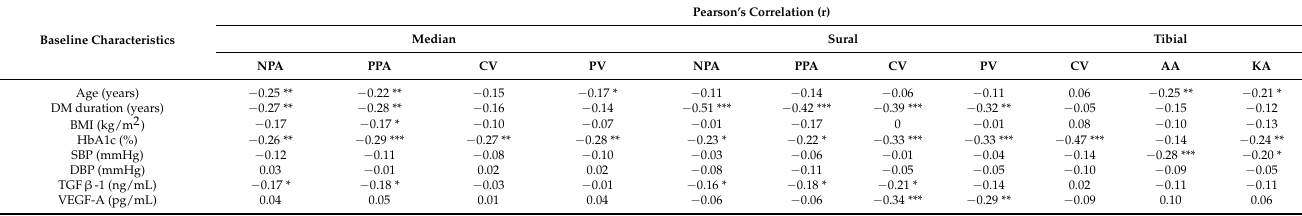
Table 2. Correlation between baseline characteristics and biomarkers with nerve conduction parameters at baseline. BaselineCharacteristics